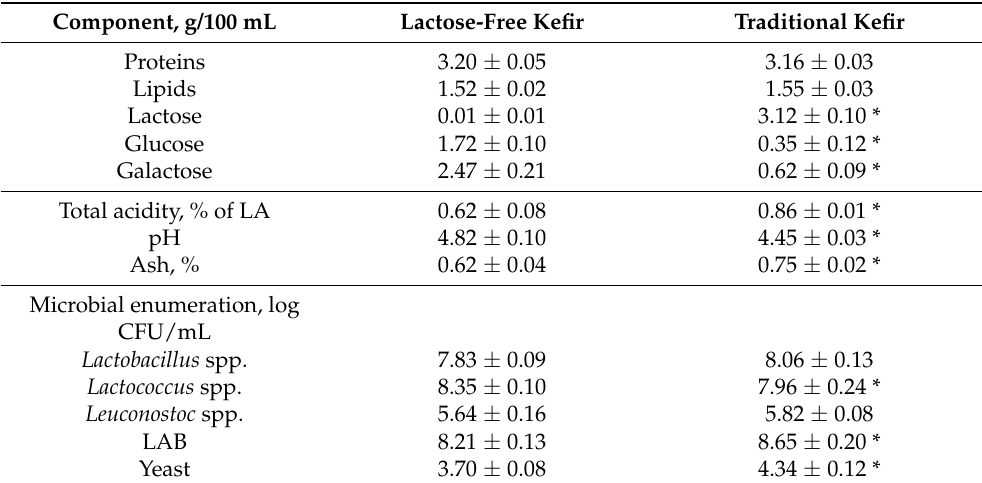
Table 1. Proximate composition and microbial count of kefir samples (n = 9) stored for 7 days. Component, g/100 mL Lactose-Free Kefir Traditional